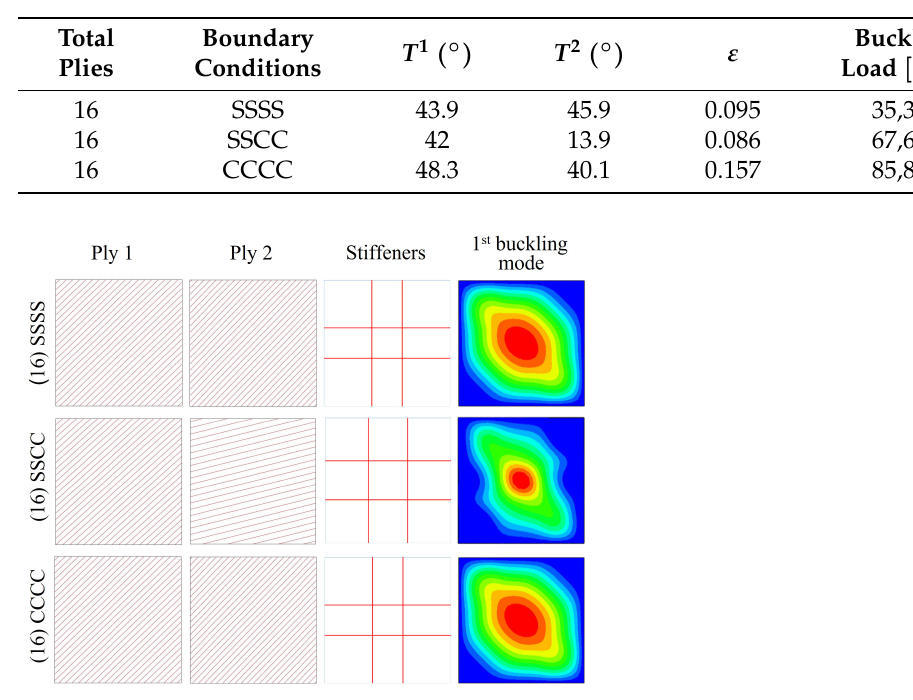
45 ◦ . The stiffener locations are towards the panel center. The critical buckling load is 35,380 N/m and the buckling mode is of global